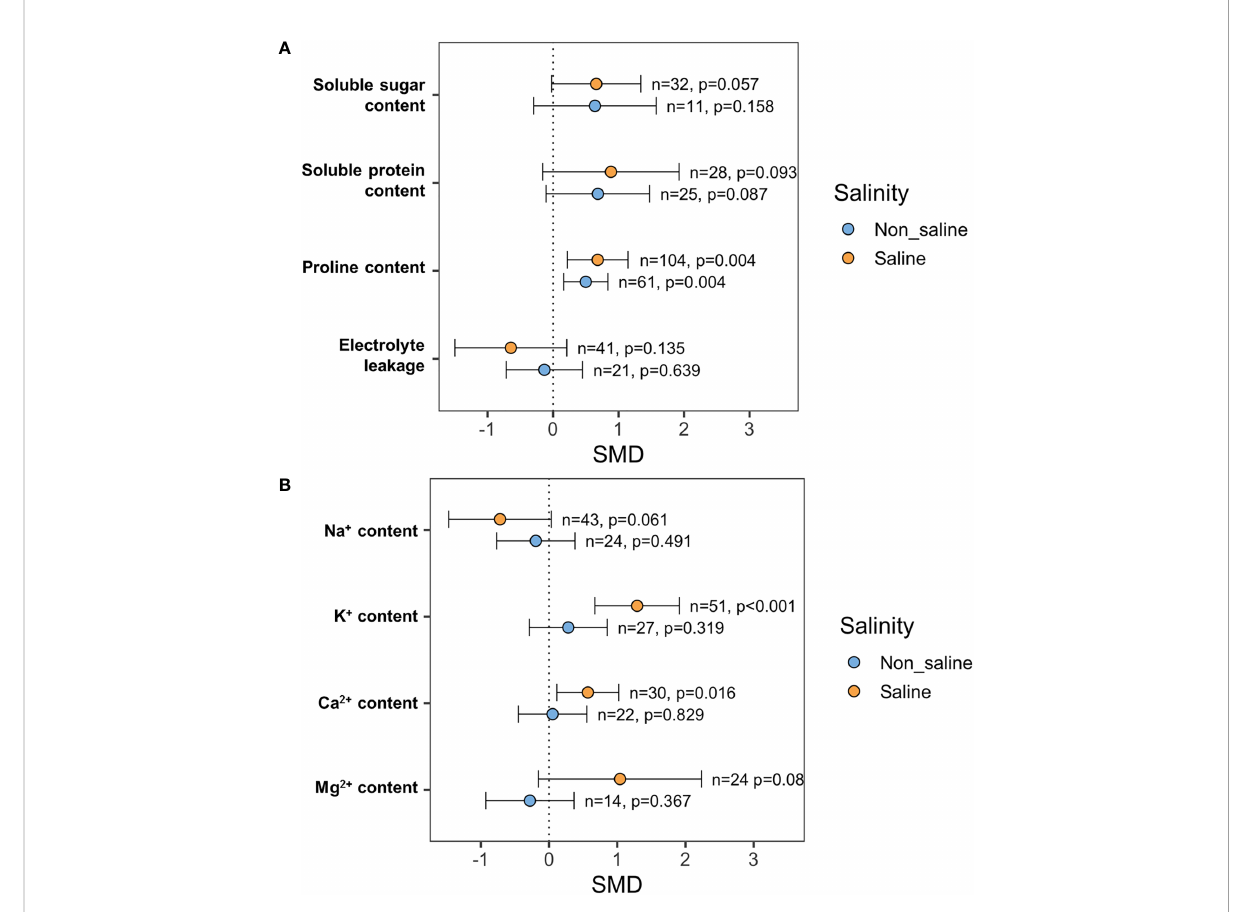
FIGURE 7 Effects of exogenous NO on (A) soluble sugars (SS), soluble proteins (SP), proline content, and electrolyte leakage (EL) and (B) Na + , K + , Ca 2+ , and Mg 2+ contents under saline and non-saline conditions. The error bars are the effect size means ±95% CIs. Where the CIs do not overlap the vertical dashed lines, the effect size for a parameter is signi fi cant, i.e., the growth responses of NO-treated plants were signi fi cantly different from those of non-NO-treated plants. n , the number of studies included in the meta-analysis; p , the signi fi cance level of